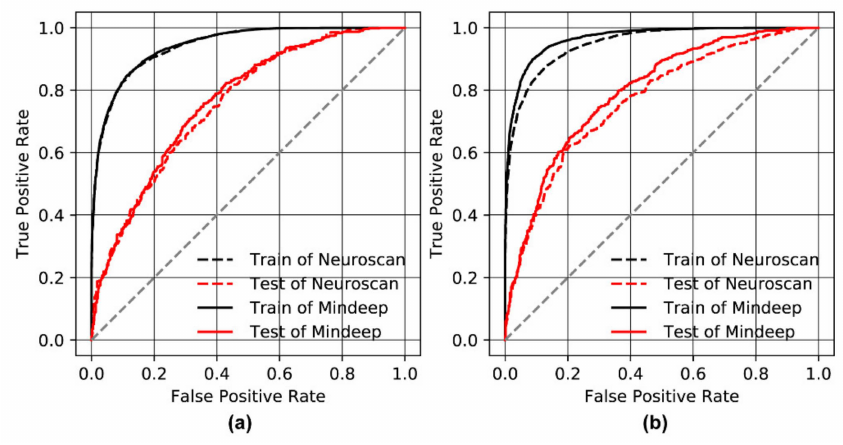
Figure 10. Accuracies and ROC curves of XGBoost model. ( a ) AX-CPT-250 ms; and ( b ) AX-CPT-125